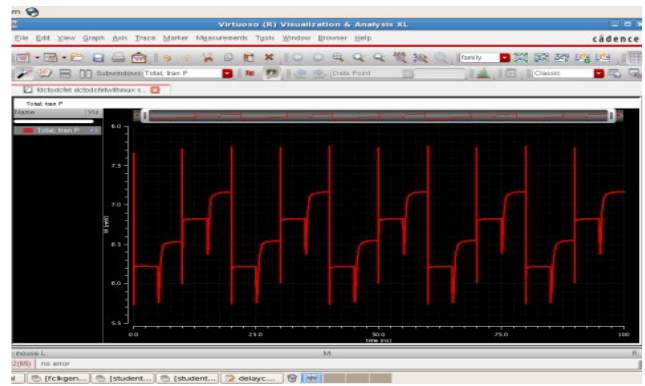
Figure 19. Power waveform for DC to DC converter Improvement in terms of delay and power can be observed by implementing the proposed dc to dc converter when compared to existing converter.